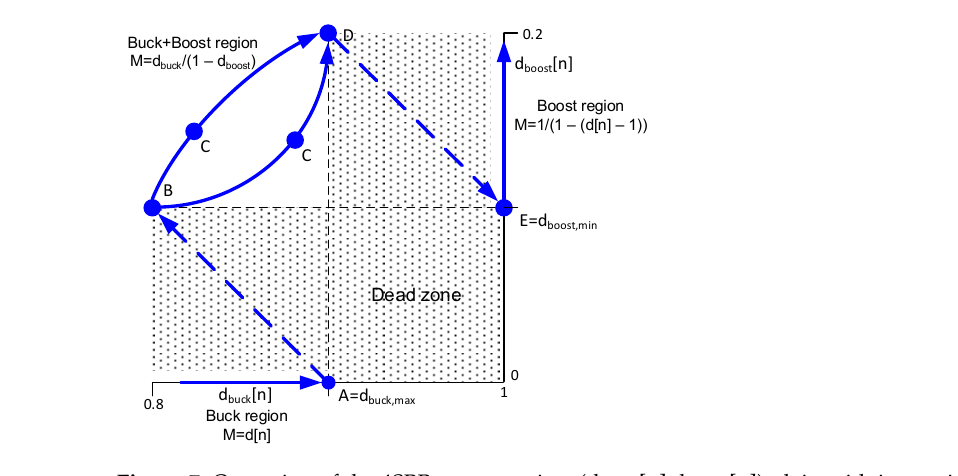
buck [n],d boost [n]) plain with increasing d[n].